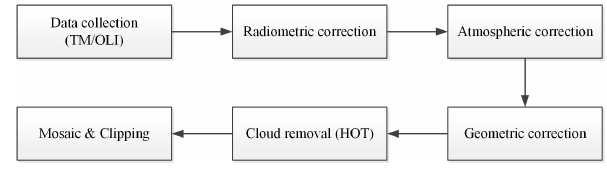
Figure 2. Preprocessing of Landsat Thematic Mapper (TM)/Operational Land Imager (OLI) scenes. Table 1. List of the latitude zones and their areas.